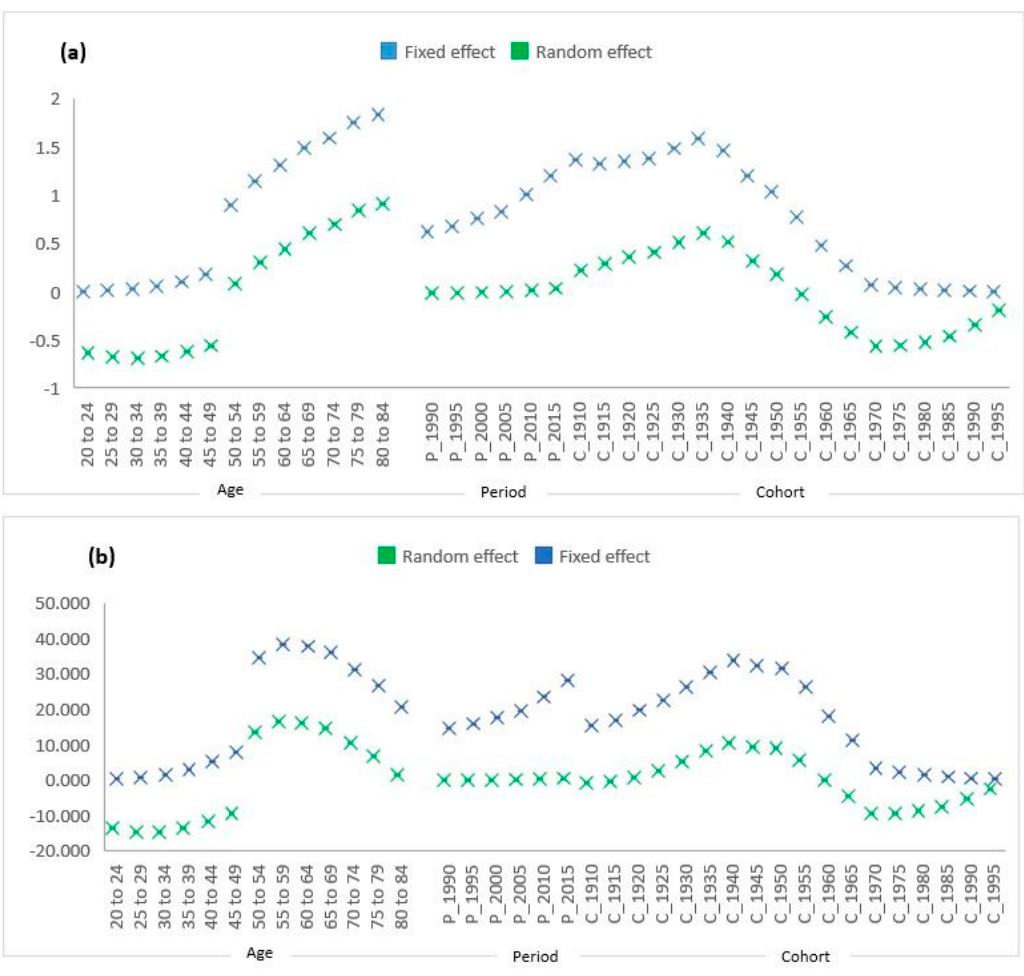
Figure 4. Fixed and random e ff ects of age, period, and cohort from hierarchical (APC) model of ( a ) MRs and ( b ) DALYs (per 100,000) from breast cancer.